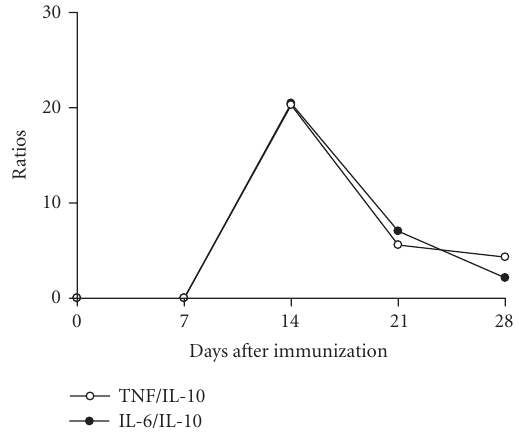
Figure 7: Kinetics of balance of pro- and anti-inflammatory cy- tokines. Groups of mice were immunized subcutaneously with 0 . 5 LD 50 of CSV as described above. The cytokines levels were deter- mined as described in “Materials and Methods.” The TNF/IL-10 and IL-6/IL-10 ratios were calculated. The experiment was repeated twice and each point represents the values of pooled sera from 5 animals (cid:0)